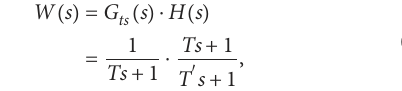
FIGURE 8 Control input without NN compensation.